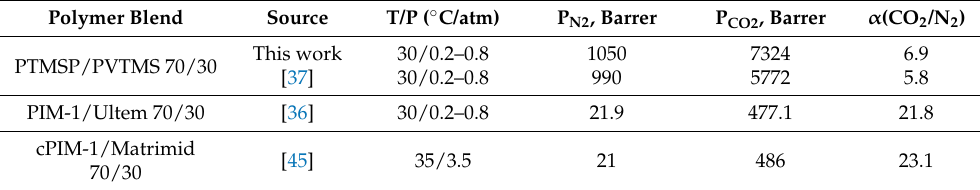
Figure 5. Gas permeability coefficients of membranes from PTMSP/PVTMS blends for gases O 2 , CO 2 , and N 2 at temperatures of ( a ) 30 and ( b ) 60 °C. Table 3. The gas permeability and selectivity data for highly permeable glassy polymer blends.